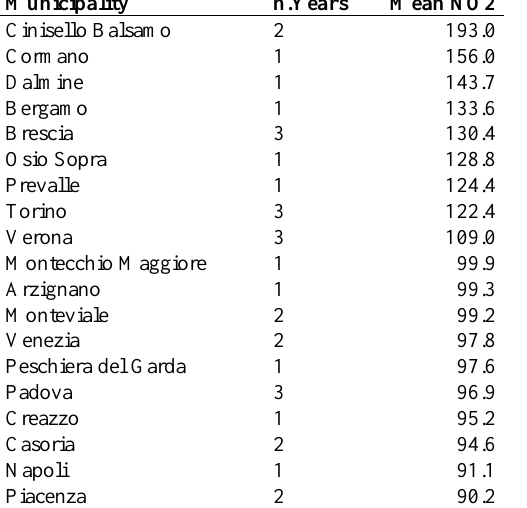
Table 5. Cites were hotspots were found from local maxima with respective average NO2 values in µmol/m 2